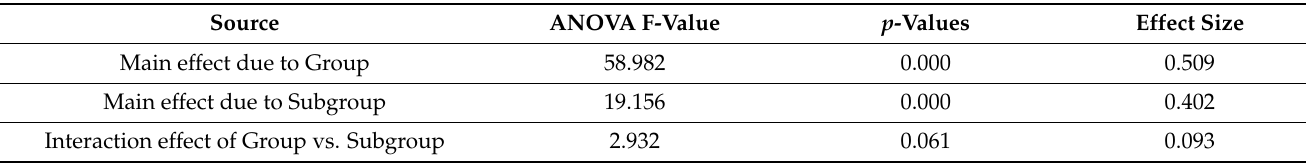
Figure 4. Confocal images depicting the depth of penetration of liposomal CHX containing rhodamine B dye into dentinal tubules. Photographs ( a , b ) depict the penetration of liposomal CHX into dentinal tubules in coronal third. Photographs ( c , d ) show liposomal CHX penetrating in middle third. ( e , f ) Liposomal CHX average penetration in apical third was less when compared with other thirds. ( g , h ) Images of penetration in the coronal and apical third, respectively of normal CHX. The penetration was significantly less as compared with liposomal CHX. Table 3. Two-way ANOVA results of depth of penetration of plain CHX solution and liposomal CHX in dentinal